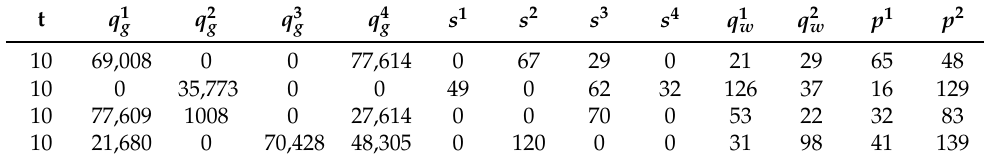
Table 3. An example of the dimension alignment of injection-production